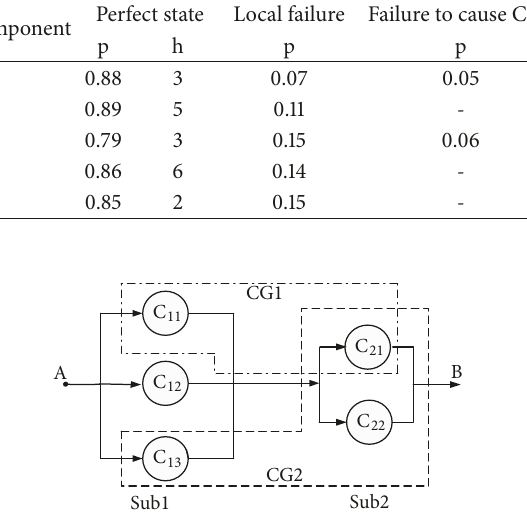
Figure 1: Series-parallel structure